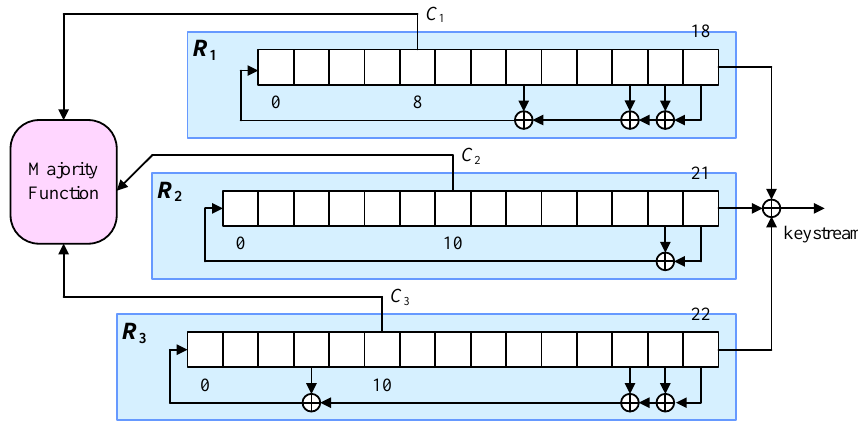
Figure 3. The diagram of A5/1 stream cipher.